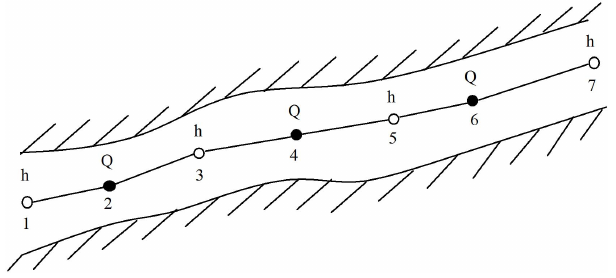
Figure 1. Water points and discharge points of the Abbott